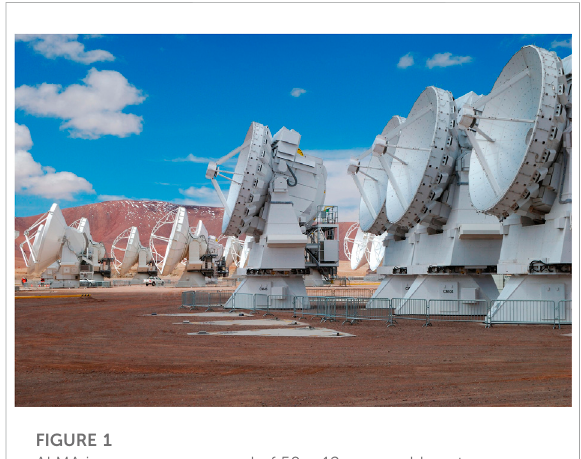
FIGURE 1 ALMA is an array composed of 50 × 12 m movable antennas (left background), 12 × 7 m fi xed antennas (right foreground), and 4 × 12 m total power antennas. Credit: